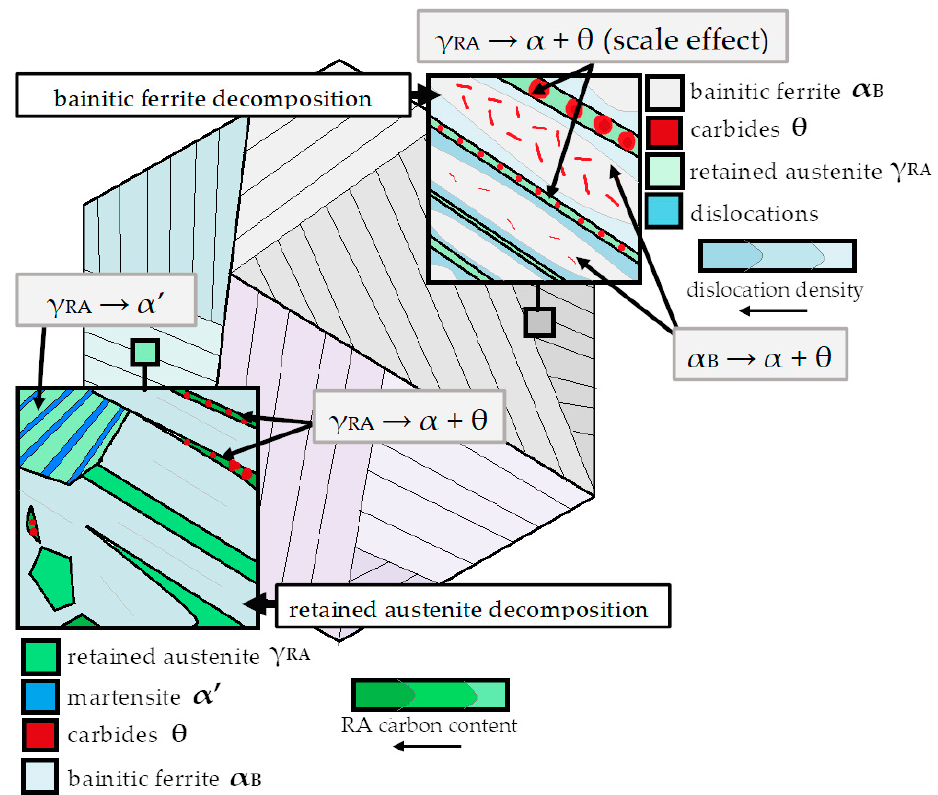
Figure 1. Scheme of main decomposition processes of retained austenite and bainitic ferrite in carbide-free bainitic structures.